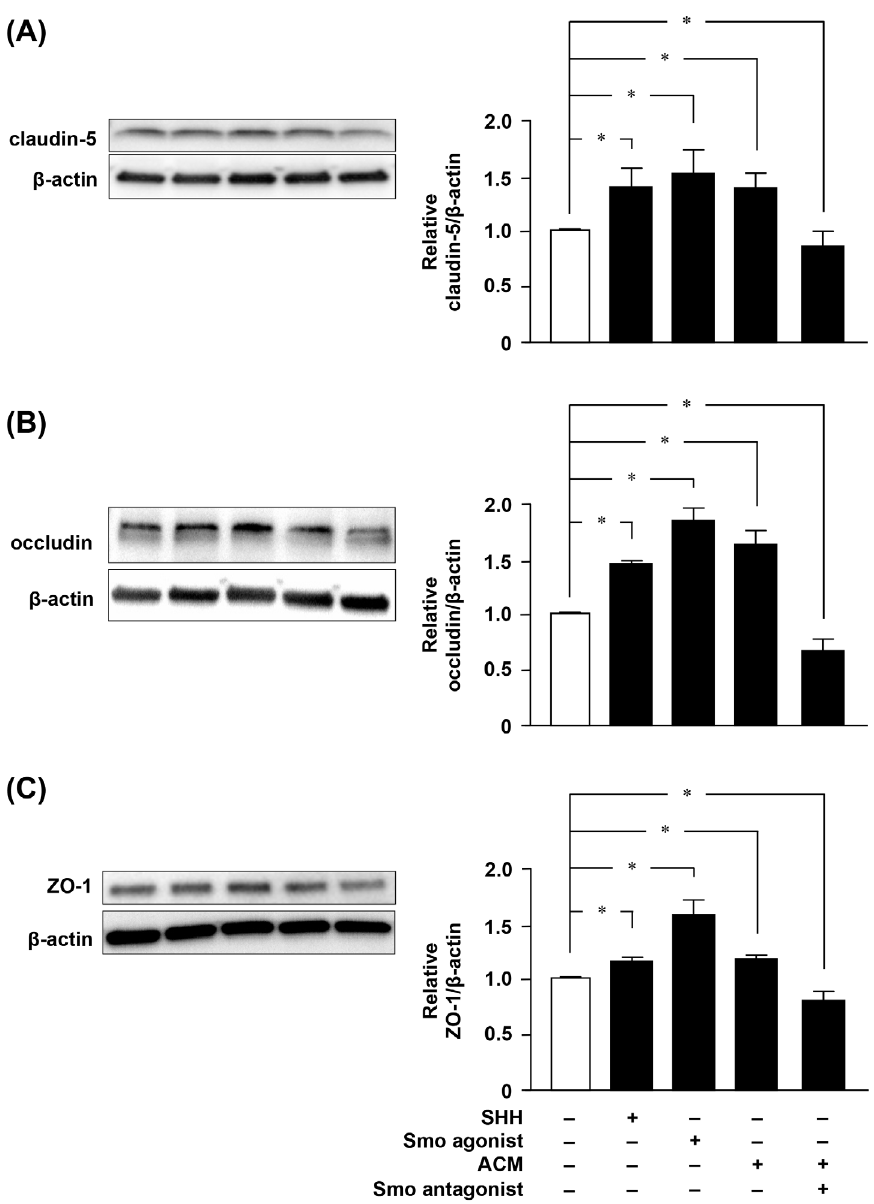
Figure 4. Astrocytic SHH signaling regulates expression of tight junction proteins in BBB. Western blotting of claudin-5 (A), occludin (B) and ZO-1 (C) in MBEC4 cells. Cells were treated for 24 h with ACM, SHH (100 ng/ml), the Smo agonist purmorphamine (1 m M), or the Smo antagonist cyclopamine (30 m M). All quantitative data are expressed as means 6 SEM (n=5), normalized to the corresponding values from untreated cells. *, p ,